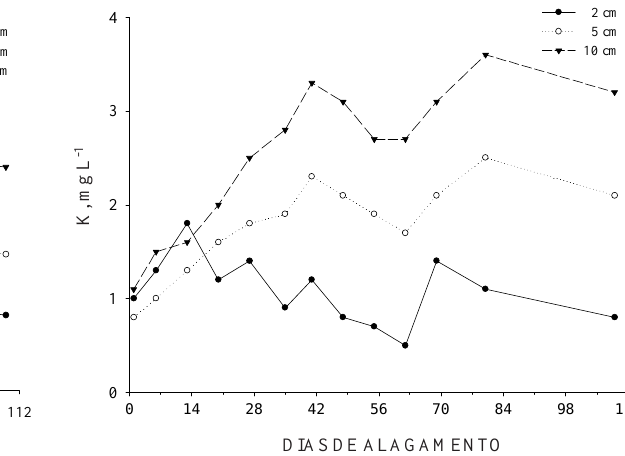
Figura 5. Concentração de cálcio na solução do solo em três profundidades de um Planossolo submetido a alagamento.